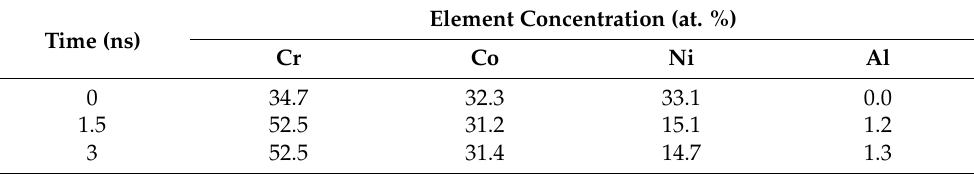
Figure 6. Element segregation process ( a – c ) and Distribution of Al elements ( d – f ) of the CrCoNiAl 0.014 alloy with medium-entropy at 0, 1.5, and 3 ns grain boundaries, respectively, at 700 K. Table 2. Atomic Concentrations of Ni, Cr, Co, and Al at Grain Boundary of the Medium-Entropy Alloy CrCoNiAl 0.014 at 300 K.